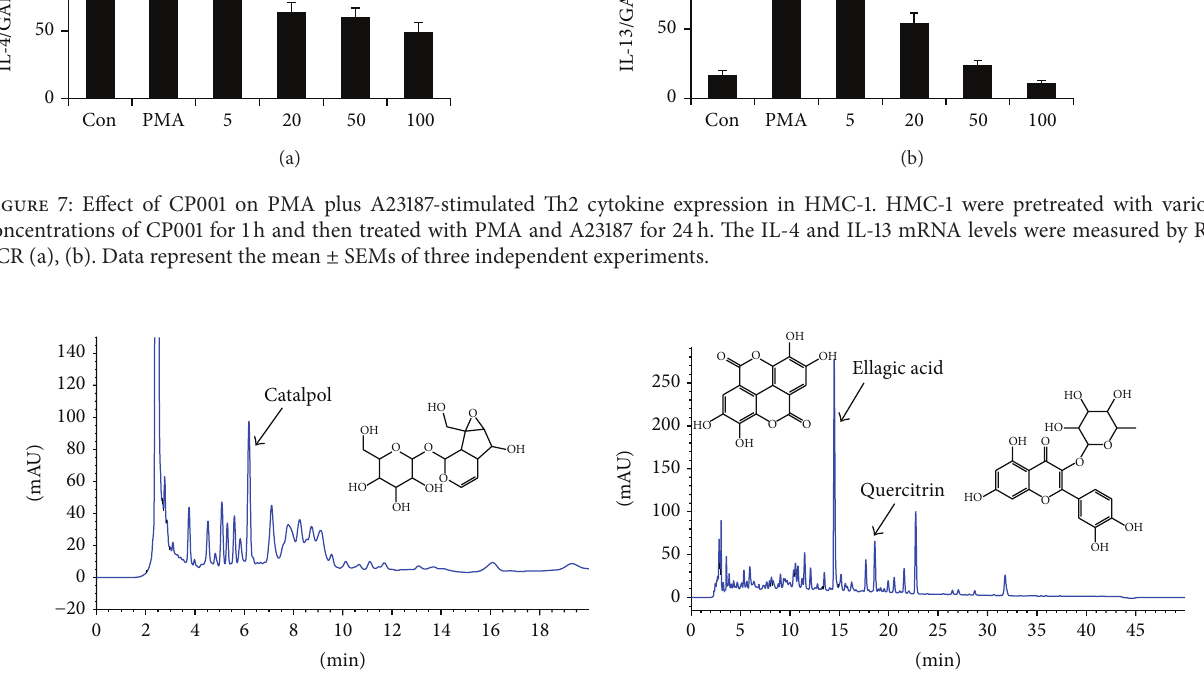
DNCB-induced AD-like skin lesion. It seems that inhibition of infiltration of mast cell downregulates secretion of IL-4 and IL-13 cytokines and it may inhibit recruitment of